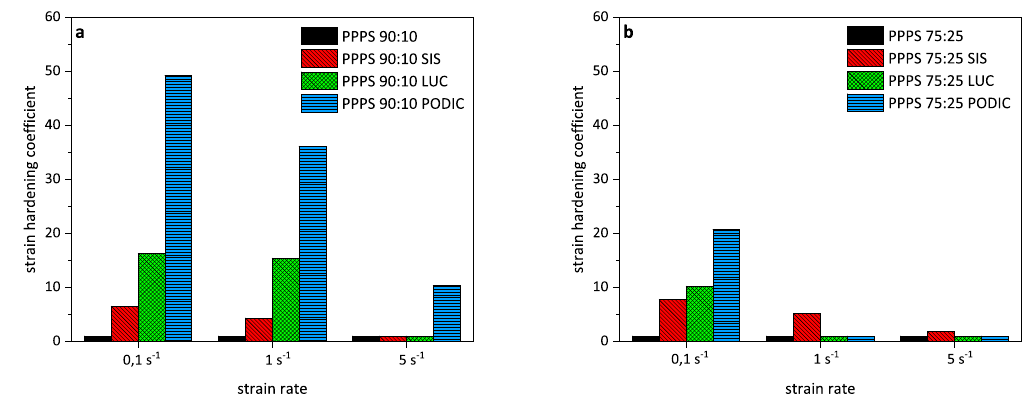
Figure 8. Strain hardening coefficients of PP–PS 90:10 ( a ) and PP–PS 75:25 ( b ) blends obtained from extensional rheology